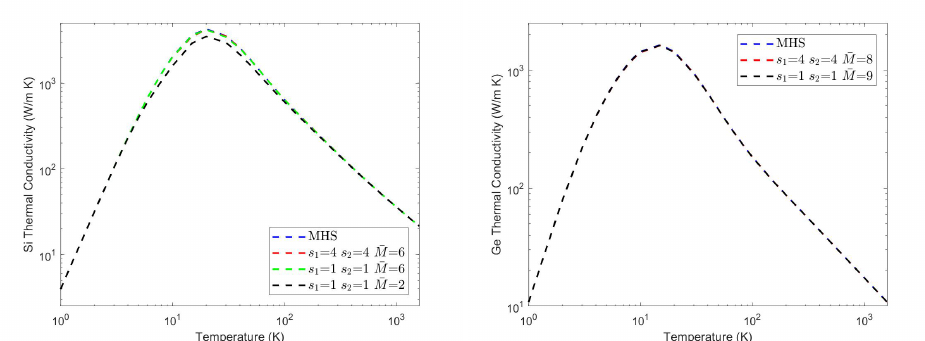
Figure 1. ( Left ): Silicon steady-state thermal conductivity vs. temperature. ( Right ): Germanium steady-state thermal conductivity vs temperature.